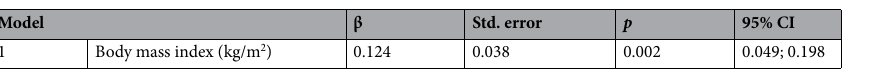
Table 5. Beta coefficients for testosterone, age and BMI in adjusted models of prediction of T score of the lumbar spine, using stepwise regression. a. Dependent variable: T score lumbar spine. b. Predictors: E2, testosterone, DHEA, androstenedione, age, race, BMI, alcohol, smoking habits, age of menarche, type of menstrual cycles, parity, age of menopause, years since menopause, vaginal estrogen use.